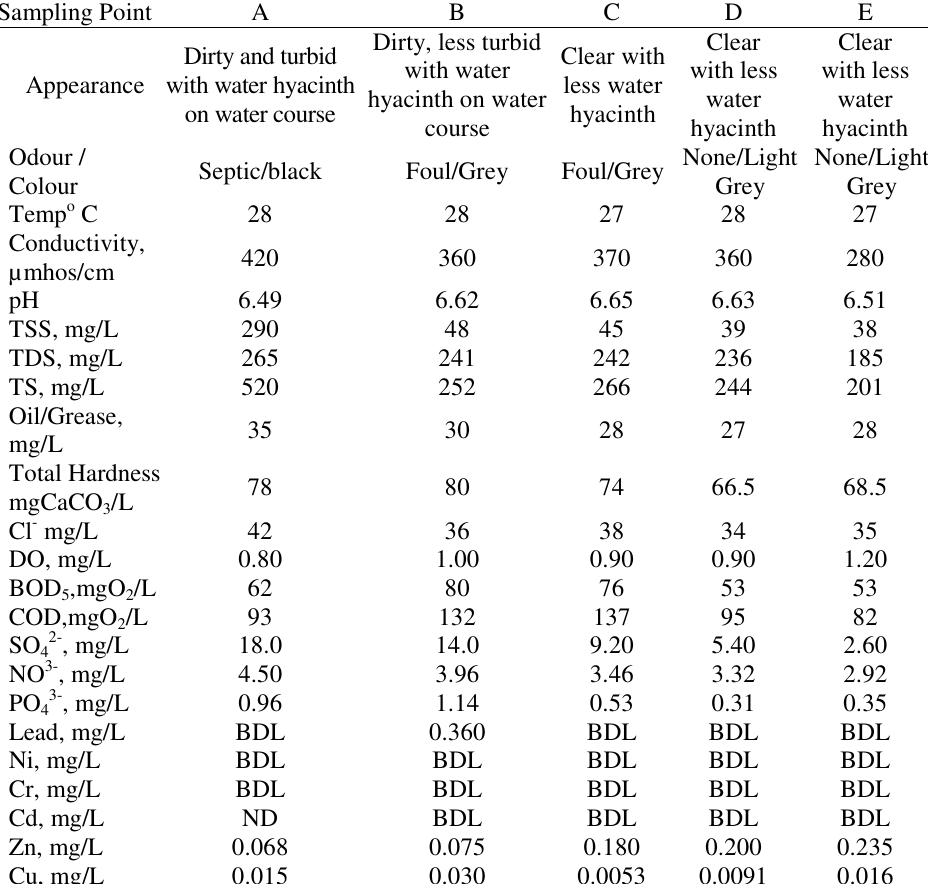
Table 1. Characteristics of water collected from the